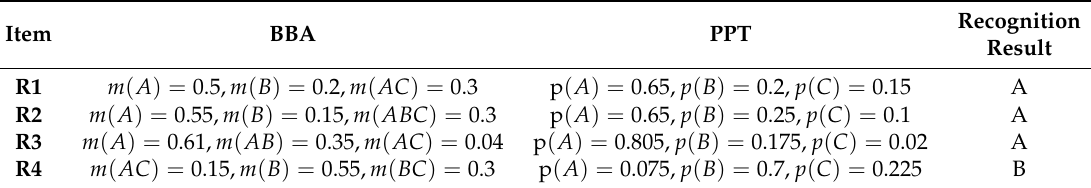
Table 3. Four pieces of evidence and their recognition